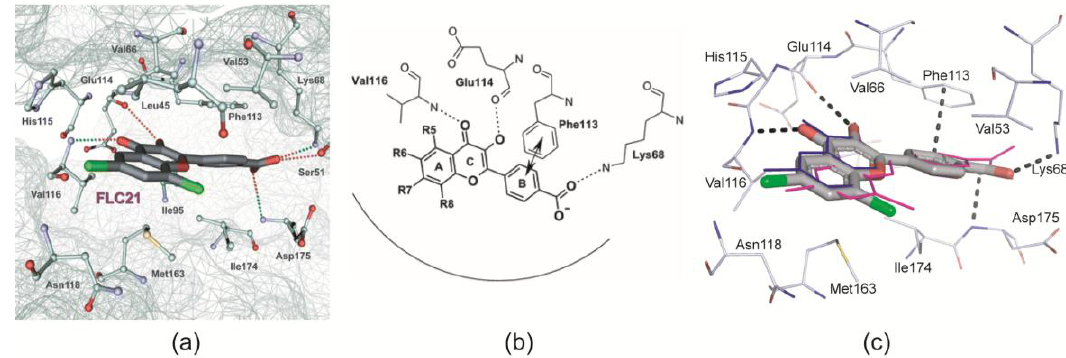
Figure 2. Binding mode of FLC21 to the ATP site of CK2α and CK2α′. ( a ) Section of a modelled CK2α/FLC21 complex as published by Golub et al. [28]. The picture is identical to Figure 6 in [28] © Springer Science + Business Media, LLC. 2011, and is reproduced with permission of Springer; ( b ) the four basic non-covalent interactions underlying the predicted model. The drawing is identical with Figure 1 in [28], © Springer Science+Business Media, LLC. 2011, reproduced with permission of Springer; ( c ) Section of a low-salt CK2α 1–335 /FLC21 complex (structure 3 in Table 1) drawn in an equivalent orientation and with a similar style as in Figure 2a in order to facilitate the comparison between the two pictures. The FLC21 ligands of structures 1, 2 and 4 (Table 1) were drawn with thin bonds after superimposition of the respective protein matrices.